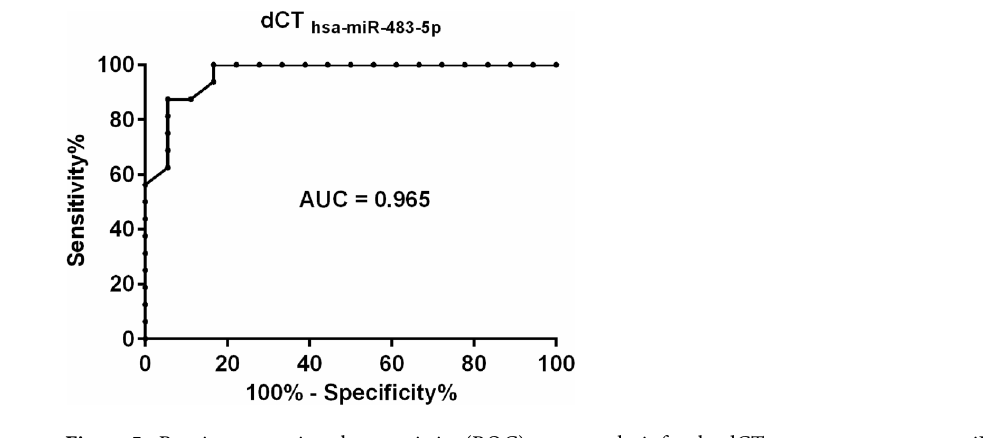
Figure 5. Receiver operating characteristics (ROC) curve analysis for the dCT hsa-miR-4835-p exosomes miRNA signature relative to housekeeping cel-miR-39 based on the results obtained from RT-qPCR analysis of ACA (n = 18) and ACC (n = 16) plasma exosomes samples.